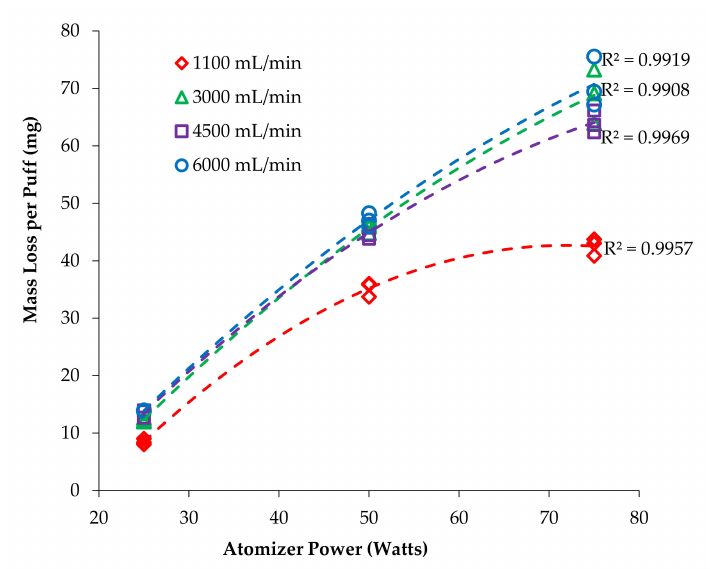
Figure 4. Effect of power on mass loss per puff for each trial at different flow rates.